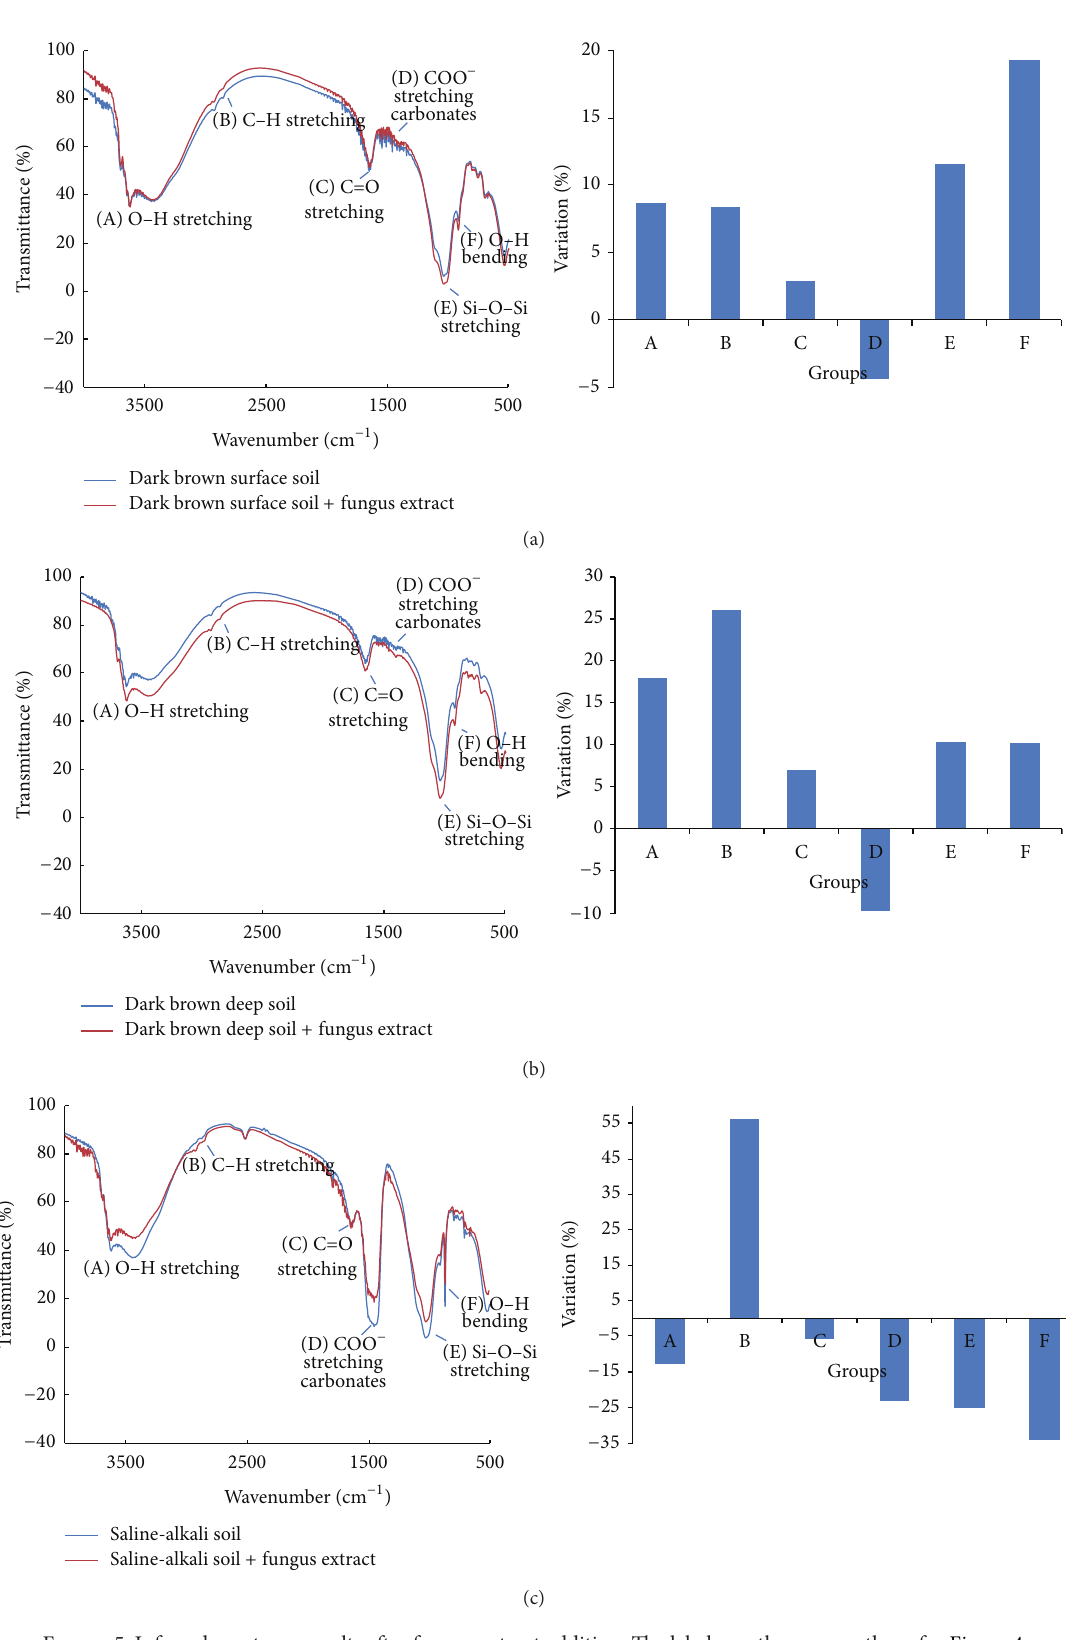
Figure 5: Infrared spectrum results after fungus extract addition. The labels are the same as those for Figure